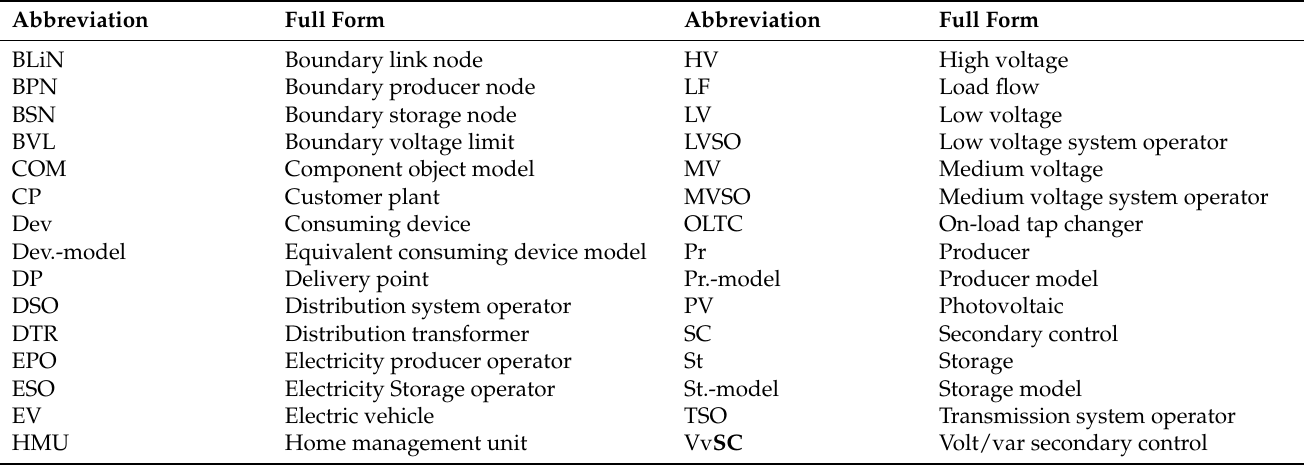
Table A1. Abbreviations and corresponding full forms.